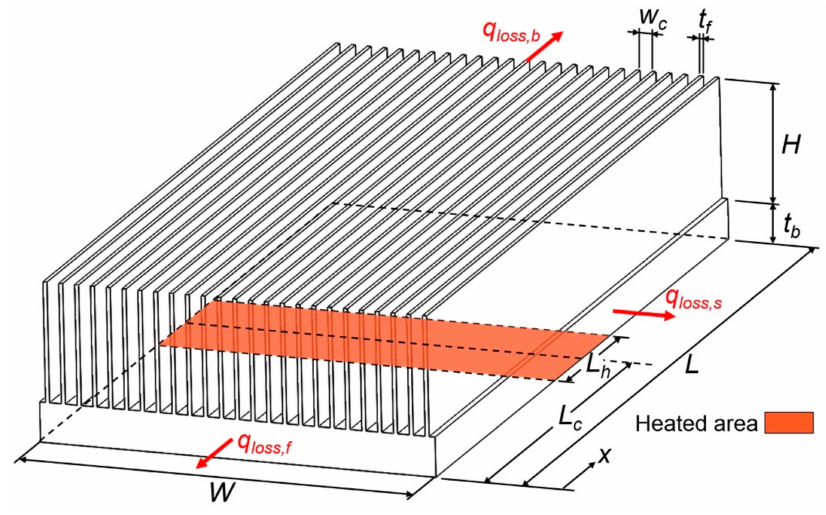
Figure 1. Plate-fin heat sinks with partial